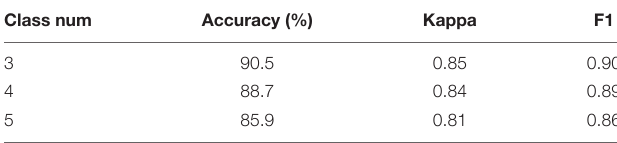
TABLE 6 | The performance of multi-class classification task based on